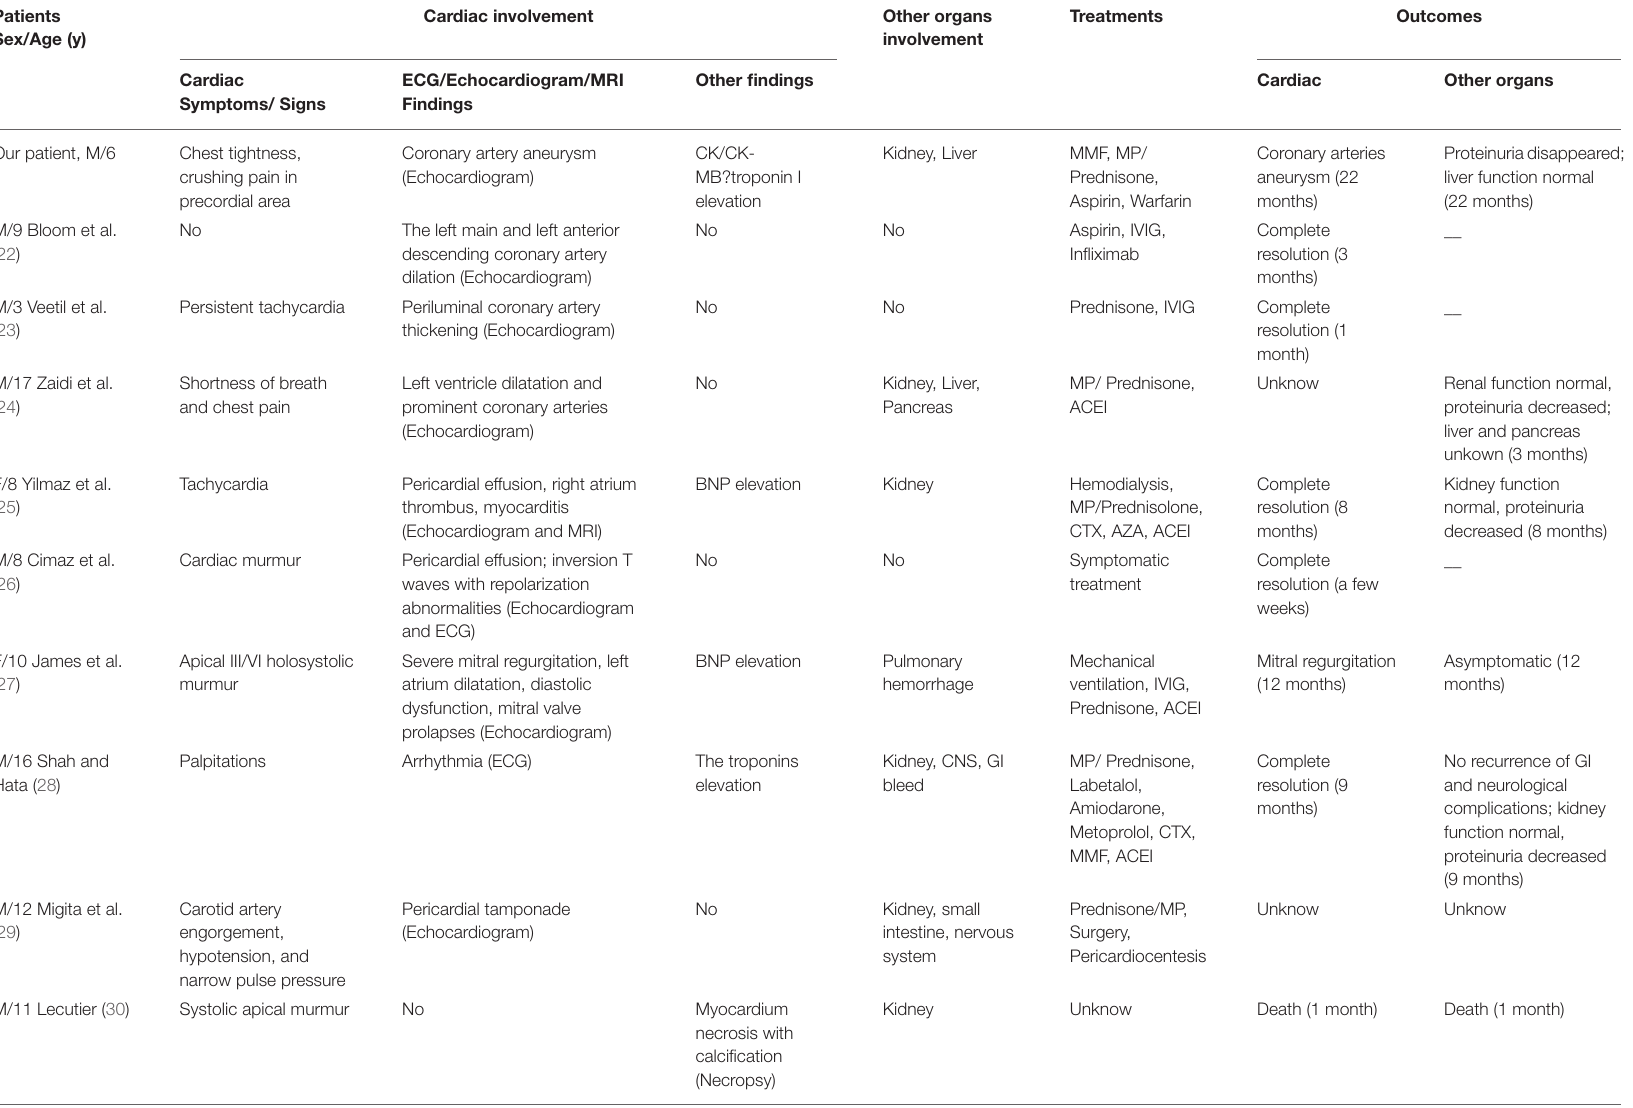
M,male; F,female; Electrocardiogram, ECG;MRI,Magnetic Resonance Imaging; BNP, Brainnatriuretic peptide; MMF, Mycophenolate mofetil; CTX,Cyclophosphamide; MP, Methylprednisolone; AZA, azathioprine; CNS,Central Nervous System; ACEI, Angiotensin Converting Enzyme Inhibitor; GI,